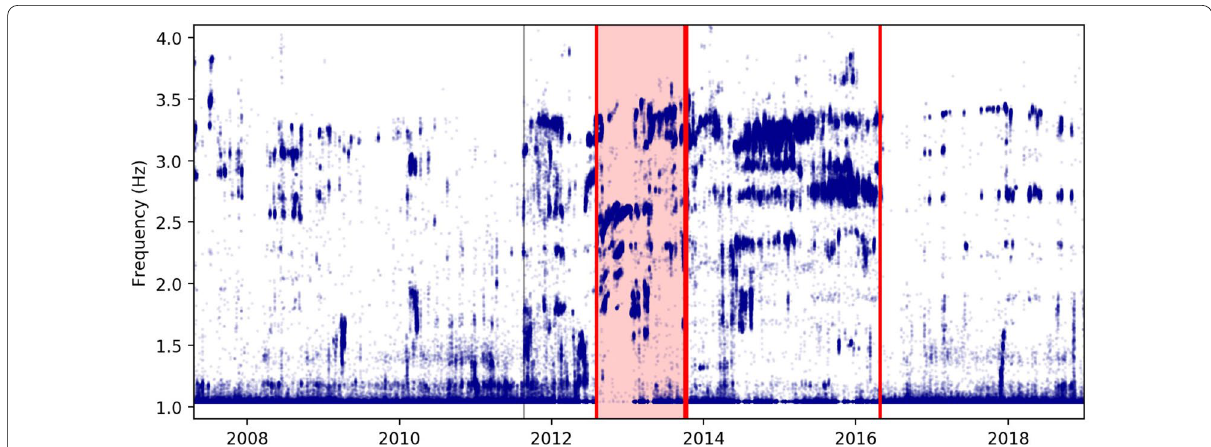
Fig. 3 Dominant frequency of tremor computed every 5 min. See text for computation details. Vertical lines correspond to key periods of volcano activity at White Island. The first black line (from left to right) marks the earthquake swarm described in Jolly et al. (2017), the red period in 2012– 2013 delineates the magmatic eruption and the last red line mark the 2016 phreatic eruptions. Each tick on the x -axis corresponds to 1 January of each year